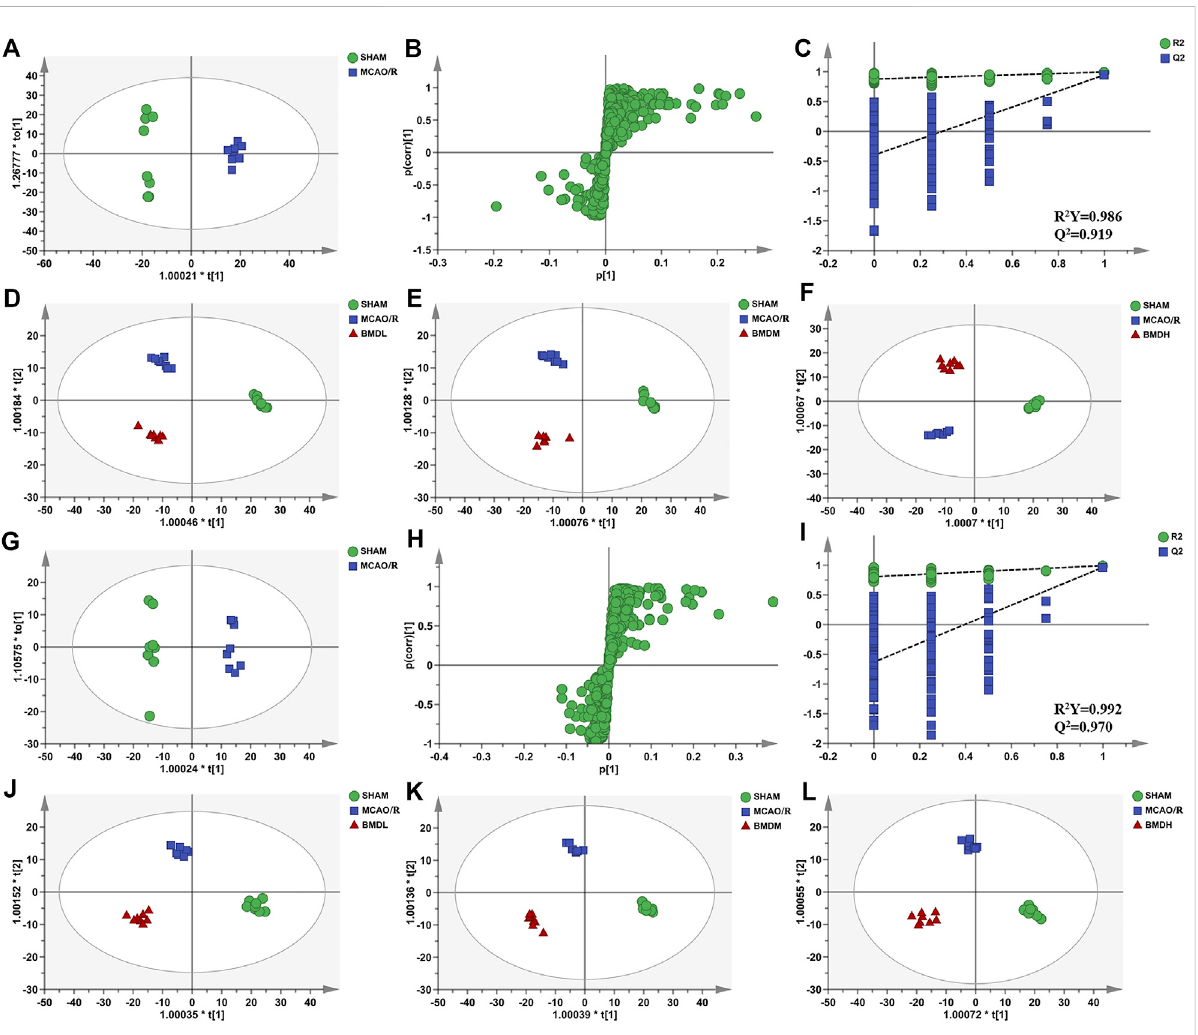
FIGURE 7 OPLS-DA score plots, S-plots, and permutation validation of brain samples. (D – F) OPLS-DA score plots of SHAM, MCAO/R, BMDL, BMDM, and BMDH in the positive mode; (J – L) OPLS-DA score plots of SHAM, MCAO/R, BMDL, BMDM, and BMDH in the negative mode; (A,G) OPLS-DA score plots of SHAM and MCAO/R in positive and negative modes, respectively; (B,H) S-plots of SHAM and MCAO/R in positive and negative modes, respectively; (C,I) permutation validation of SHAM and MCAO/R in positive and negative modes, respectively ( n =